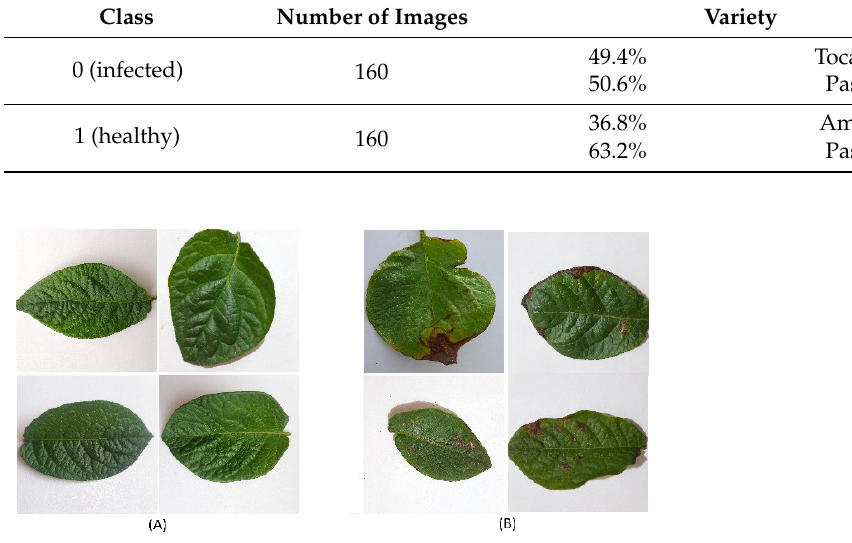
Figure 3. Samples of the data set used. ( A ) Healthy leaves, ( B ) leaves infected with late blight.